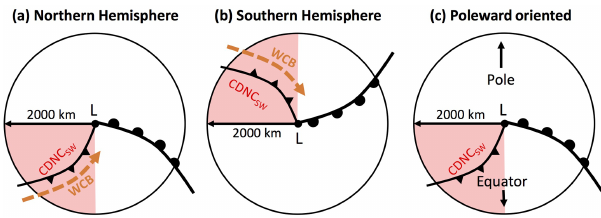
Figure 1. Schematic illustrations of an idealized cyclone in the Northern Hemisphere (a) , Southern Hemisphere (b) , and flipped so they are poleward oriented (c) . All cyclone composites in this study are presented in poleward-oriented format. The approximate loca- tion of the cold front is shown with triangles and the warm front is shown with half-circles. The approximate warm conveyor belt (WCB) location is indicated in orange and the low is indicated with an L . The 2000km radius of averaging is indicated. The averaging region used to calculate CDNC SW is shown using red